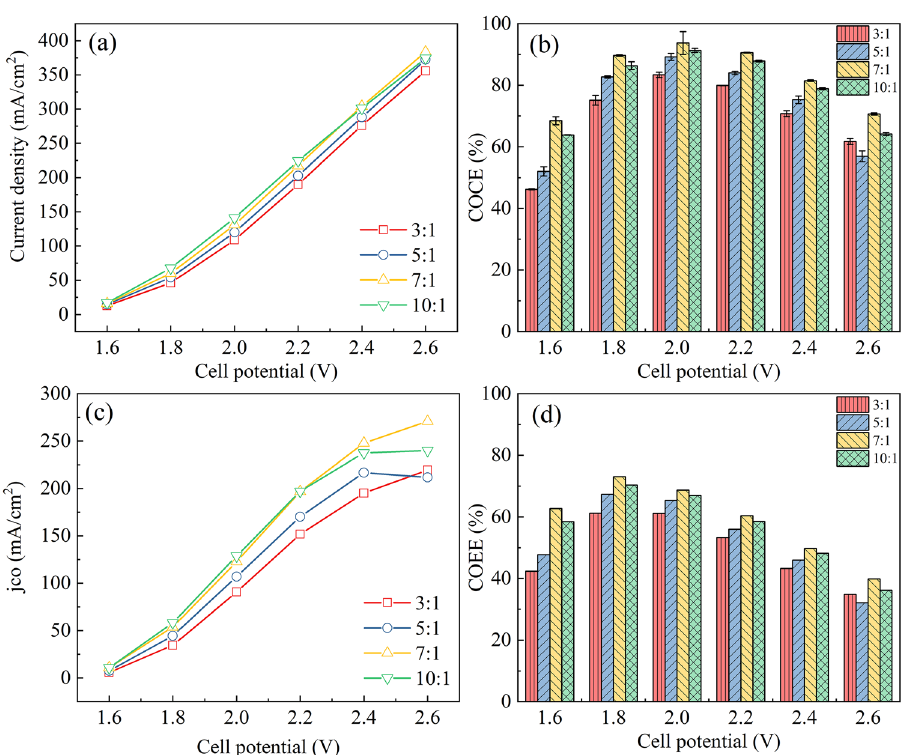
Figure 6. Cell performance of the electrodes with different PTFE contents. (a) j total and (c) j CO , (b) COCE and (d) COEE, as a function of the cell